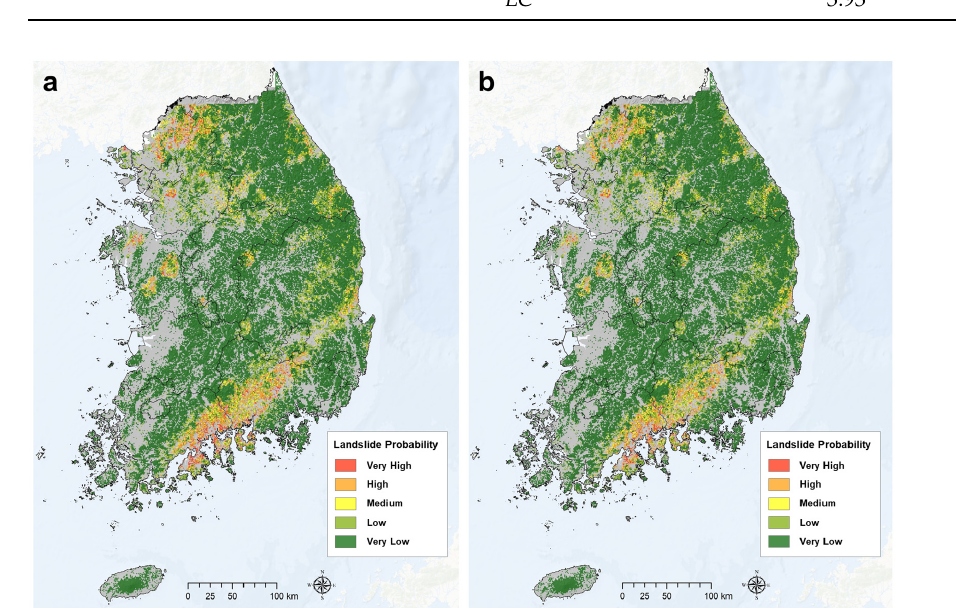
Figure 6. Landslide probability of 2050: ( a ) only climate scenario applied, and ( b ) both climate and adaptive scenarios applied. Table 4. Landslide probability distribution of each